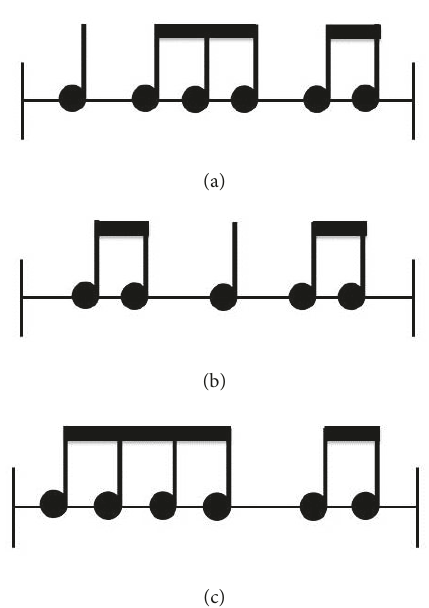
Figure 1: Different rhythms to represent three historical themes.